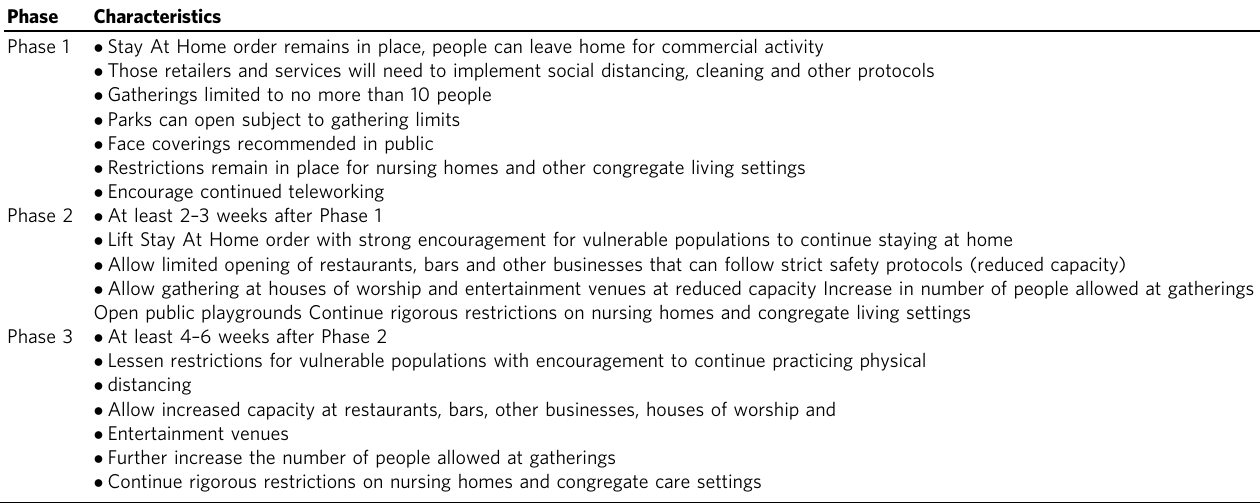
Table 2 North Carolina ’ s three phase plan for easing restrictions as described in the informational slides at the April 23, 2020 media brie fi